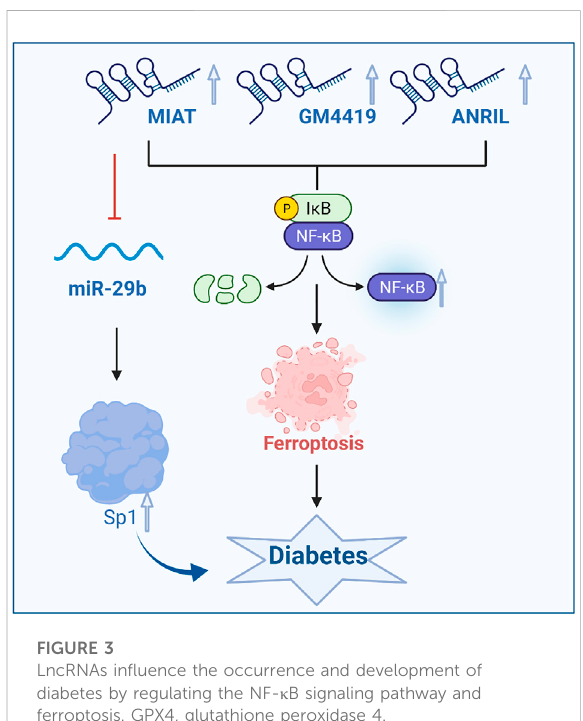
FIGURE 3 LncRNAs in fl uence the occurrence and development of diabetes by regulating the NF- κ B signaling pathway and ferroptosis. GPX4, glutathione peroxidase